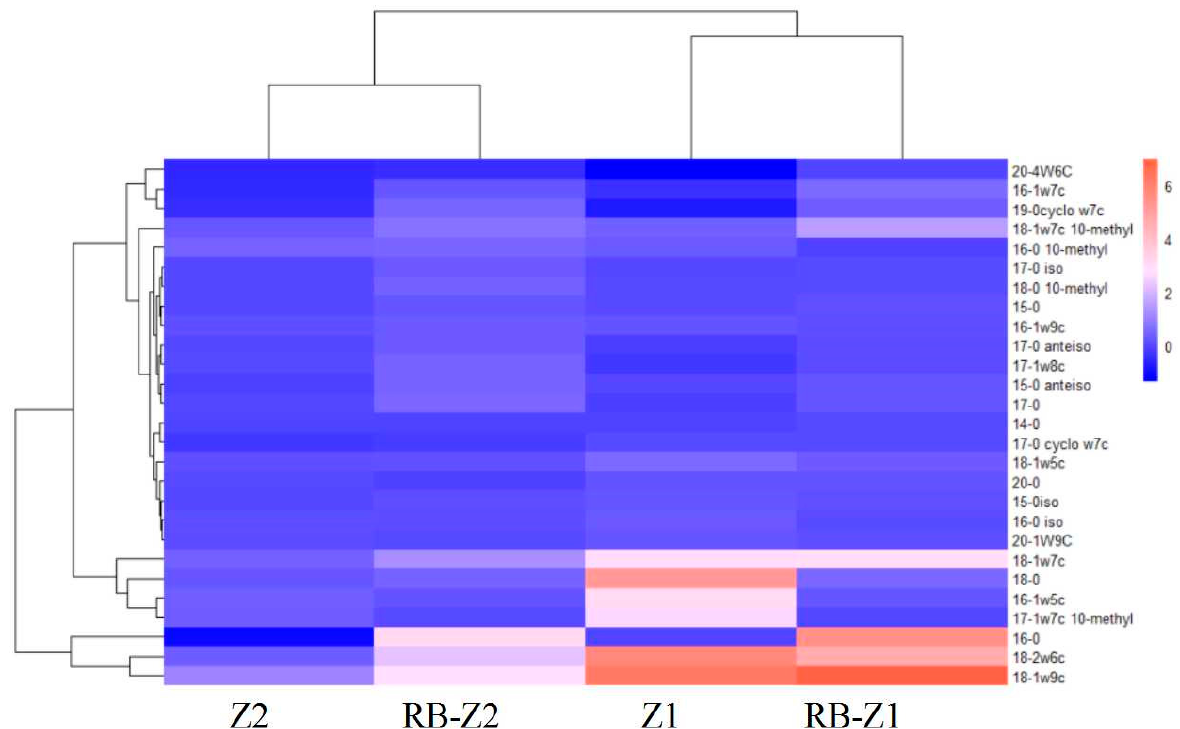
Figure 5. The 13 C isotope ‐ labeled PLFAs in soil of different treatments.